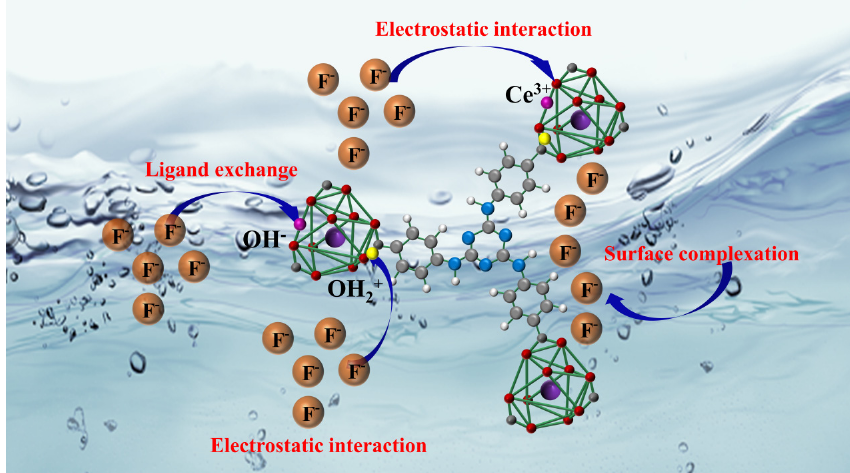
Figure 8. Mechanism schematic of Ce-H3TATAB-MOFs for de fl uoridation.